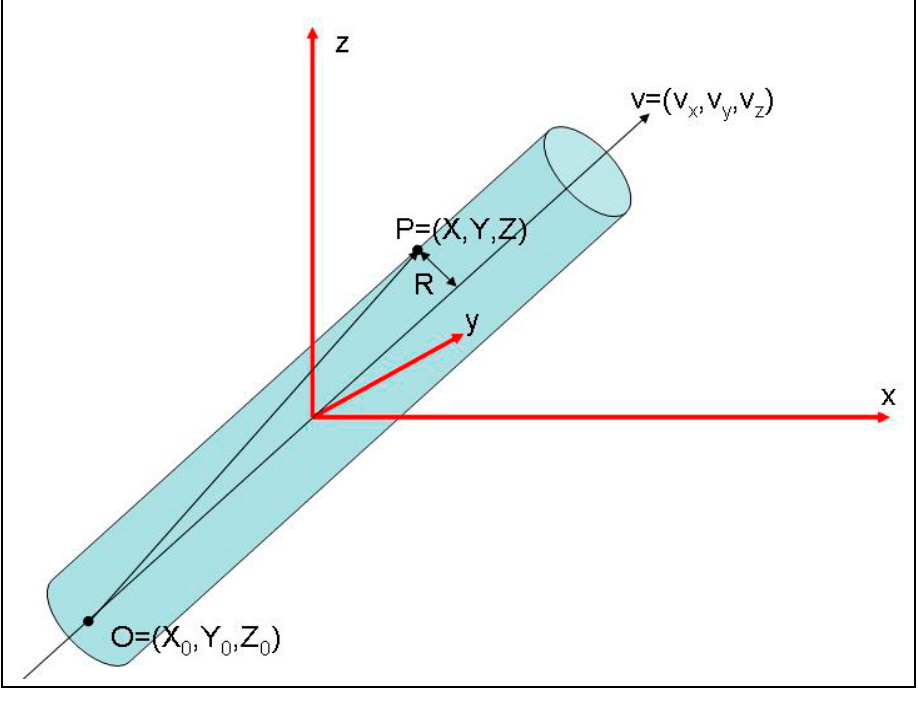
Figure 5. Cylindrical field between two electrodes.